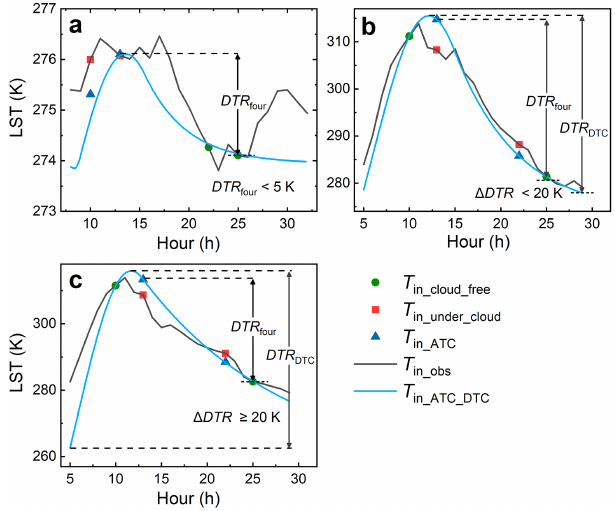
Figure 4. Estimation of T dm under different conditions. Panel (a) displays an example of estimating T dm by averaging T in_cloud_free and T in_ATC when DTR four is less than 5.0K (i.e., Scenario no. 1); panel (b) displays an example of estimating T dm based on the DTC modeling results (i.e., Scenario no. 2); panel (c) displays an example of estimating T dm by averaging T in_cloud_free and T in_ATC when (cid:49) DTR is equal or greater than 20.0K (i.e., Scenario no. 3). The green circles, red rectangles, and blue triangles denote the instantaneous cloud-free LST observa- tions, under-cloud LST observations, and under-cloud LSTs recon- structed by the ATC model, respectively. The black lines denote the in situ LST observations, while the blue lines show the DTC- modeled values based on the cloud-free LST observations and ATC- modeled under-cloud LSTs. Note that hours larger than 24 along the x axis correspond to the next